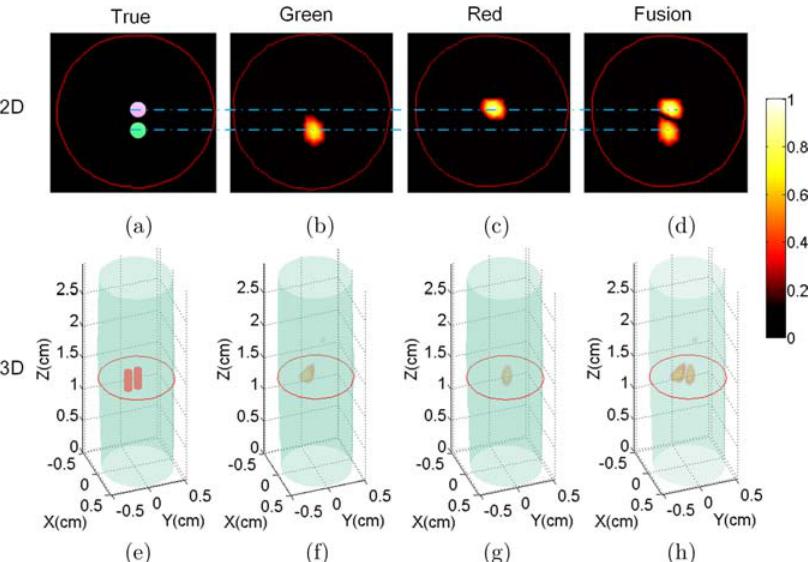
Fig. 7. Cross-sections and 3D reconstruction results of single-colored °uorescent objects. (a) – (d) Cross-sections at the height of Z = 1.3 cm. (a) Real position of the two single-colored °uorescent objects in the phantom. A capillary quartz tube that contains red quantum dot solution is placed at the center of the phantom (pink spot), and another tube that contains green quantum dots is placed 0.78 mm beside the center one (green spot). Reconstruction results with measurements at the center wavelength of (b) 530 nm and (c) 620 nm, respectively. (d) Fusion image of the reconstructed objects at 530 nm and 620 nm. (e) Real positions of the two single-colored °uorescent objects in three dimensions. Reconstructed 3D objects with measurements at the center wavelength of (f) 530 nm and (g) 620 nm, respectively, and (h) the fusion result of (f) and (g). The geometric centroids of both the reconstructed objects and the real objects are depicted with two blue dashed lines. The separation between the two reconstructed capillary tubes is calculated to be 0.59 mm. The red circles on the cross-sections indicate the phantom boundary, while the red circles on the 3D images indicate the position of